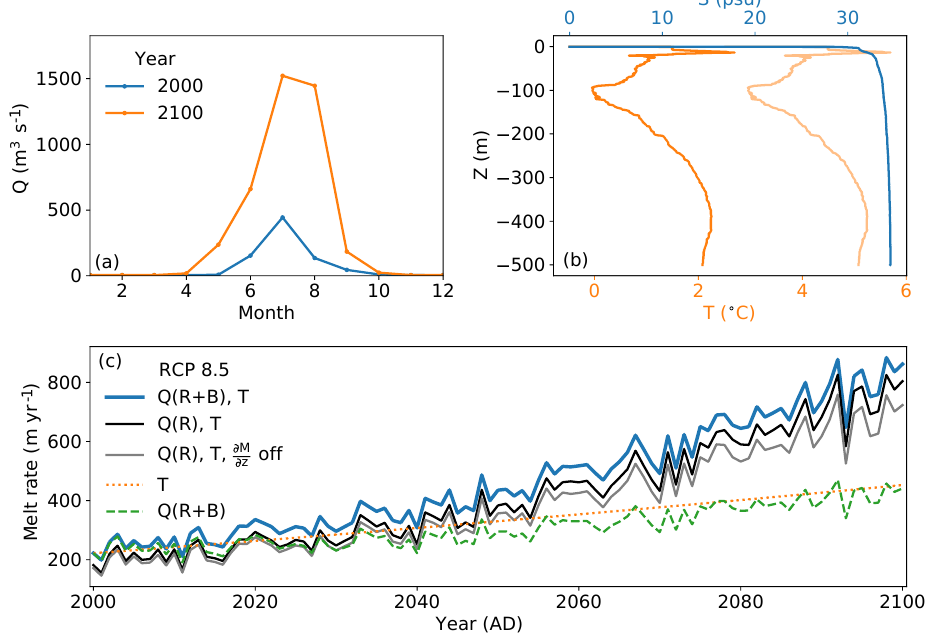
Figure 13. Similar to Fig. 12, but for Store